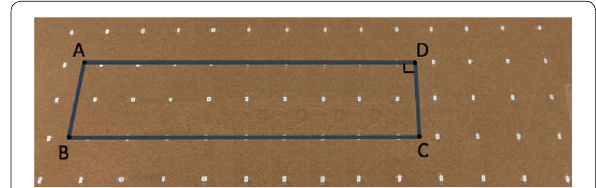
Fig. 8 Experimental environment for estimating the real-time localization on a trajectory (represented by the blue